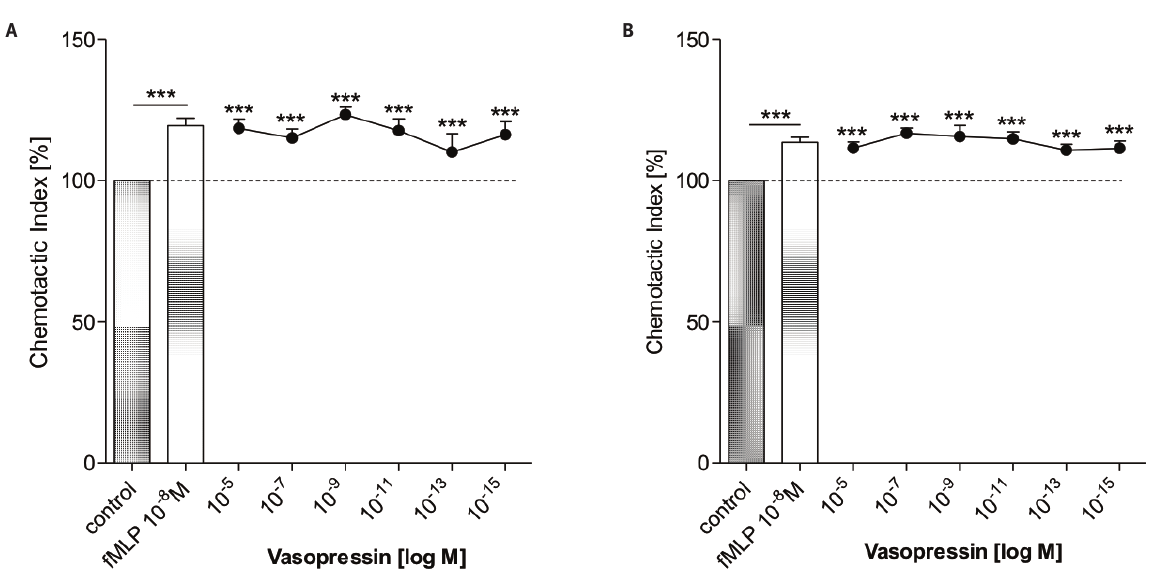
Figure 1: Direct chemotaxis against different concentrations of AVP PMNs (A) and monocytes (B) remained untreated and were allowed to migrate towards medium (control), fMLP [10 -8 M] and different concen- trations of AVP. After fixing and staining the filters, migration depth was evaluated microscopically. Data are expressed as mean ± SD of the Chemotactic Index, which is the ratio between the distance that cells migrated towards the tested substances and that toward the control medium. Statistical analyses: Mann-Whitney U test [**, p<0.01, ***, p<0.0001]